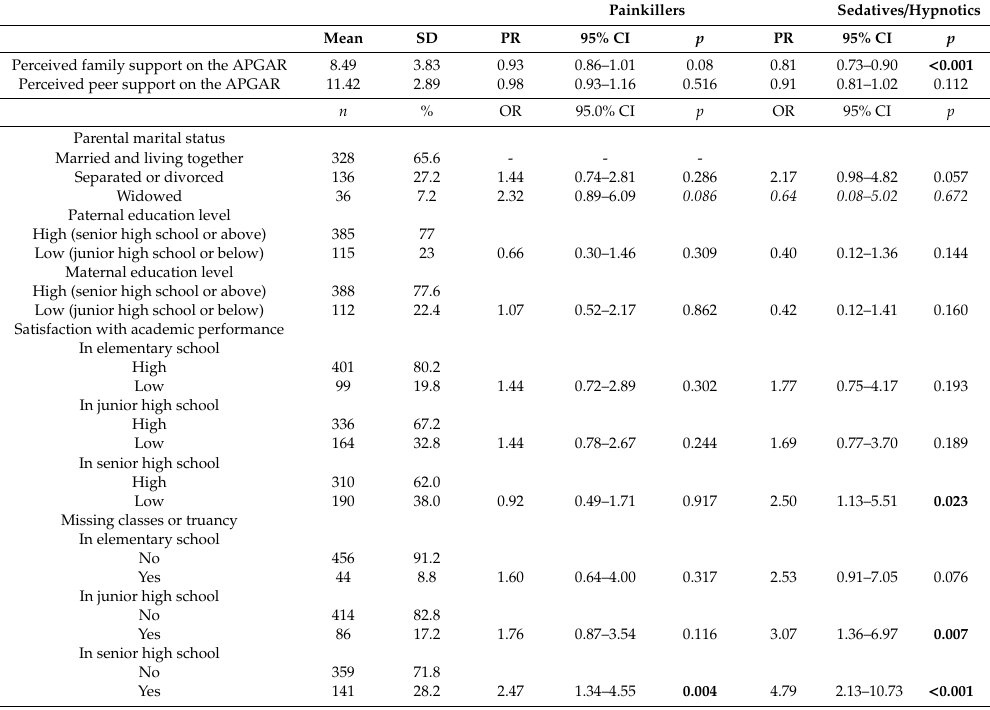
Table 3. Family, peer and school factors related to painkillers and sedatives / hypnotics use examined by univariate logistic regression ( n = 500).